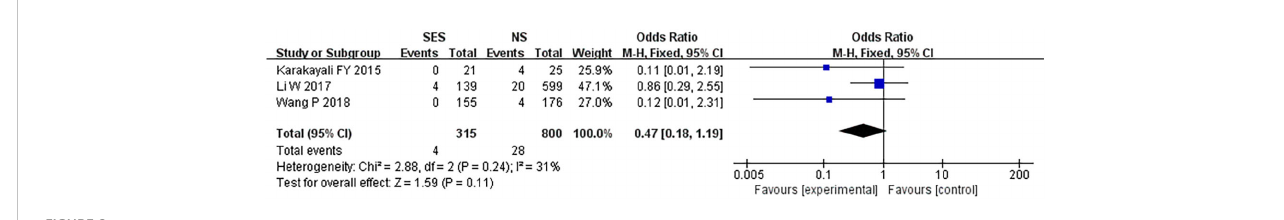
FIGURE 8 Wound infection. NS: new